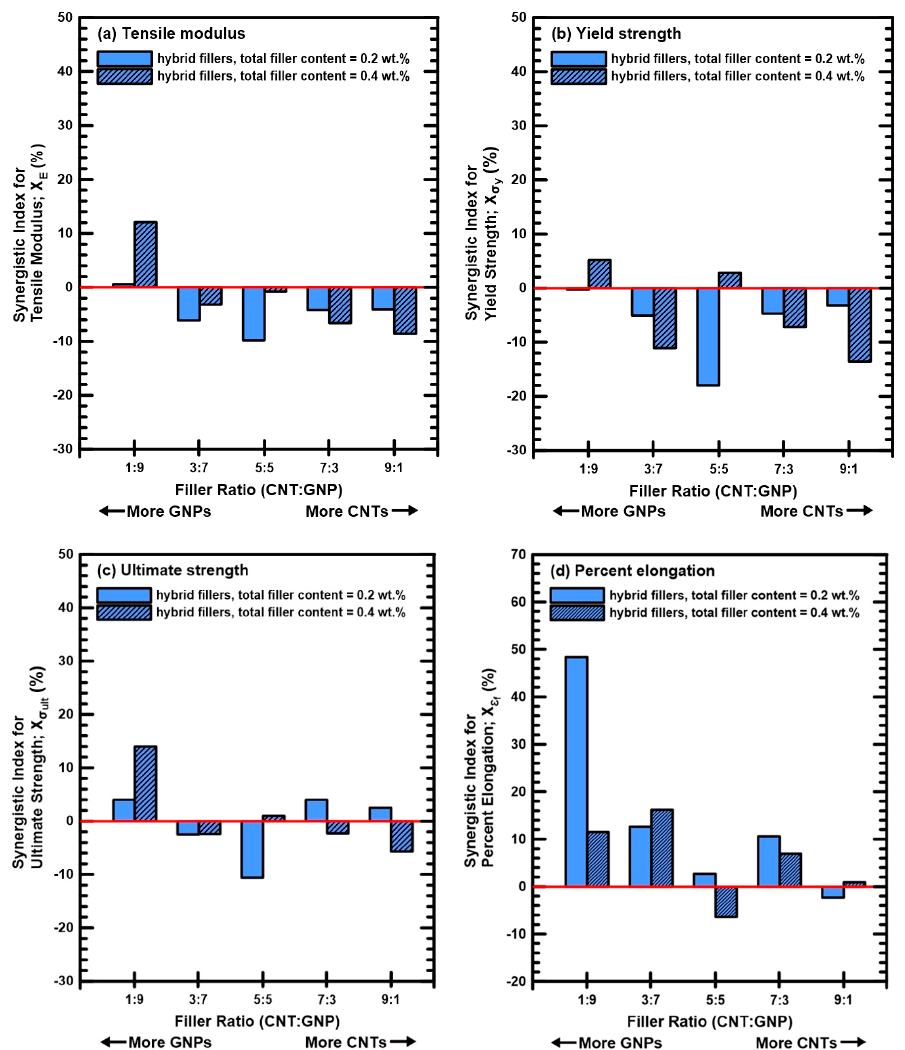
Figure 6. Synergistic indexes χ for the mechanical properties obtained in the monotonic tensile tests for the nanocomposites with various filler ratios: ( a ) tensile modulus E , ( b ) yield strength σ y , ( c ) ultimate strength σ ult , and ( d ) percent elongation ε f